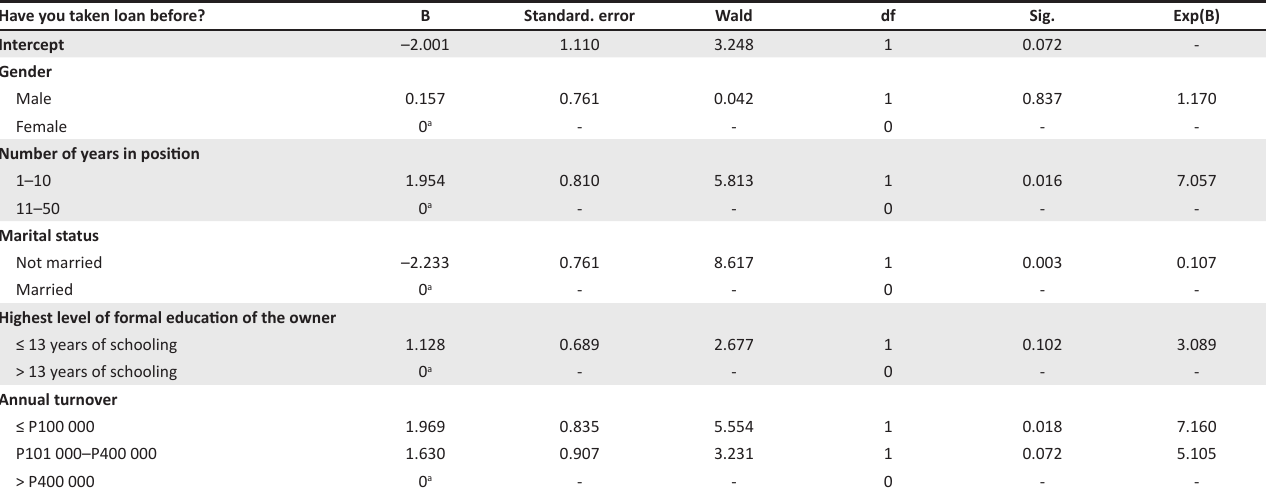
TABLE 5: Multivariate logistic regression results.